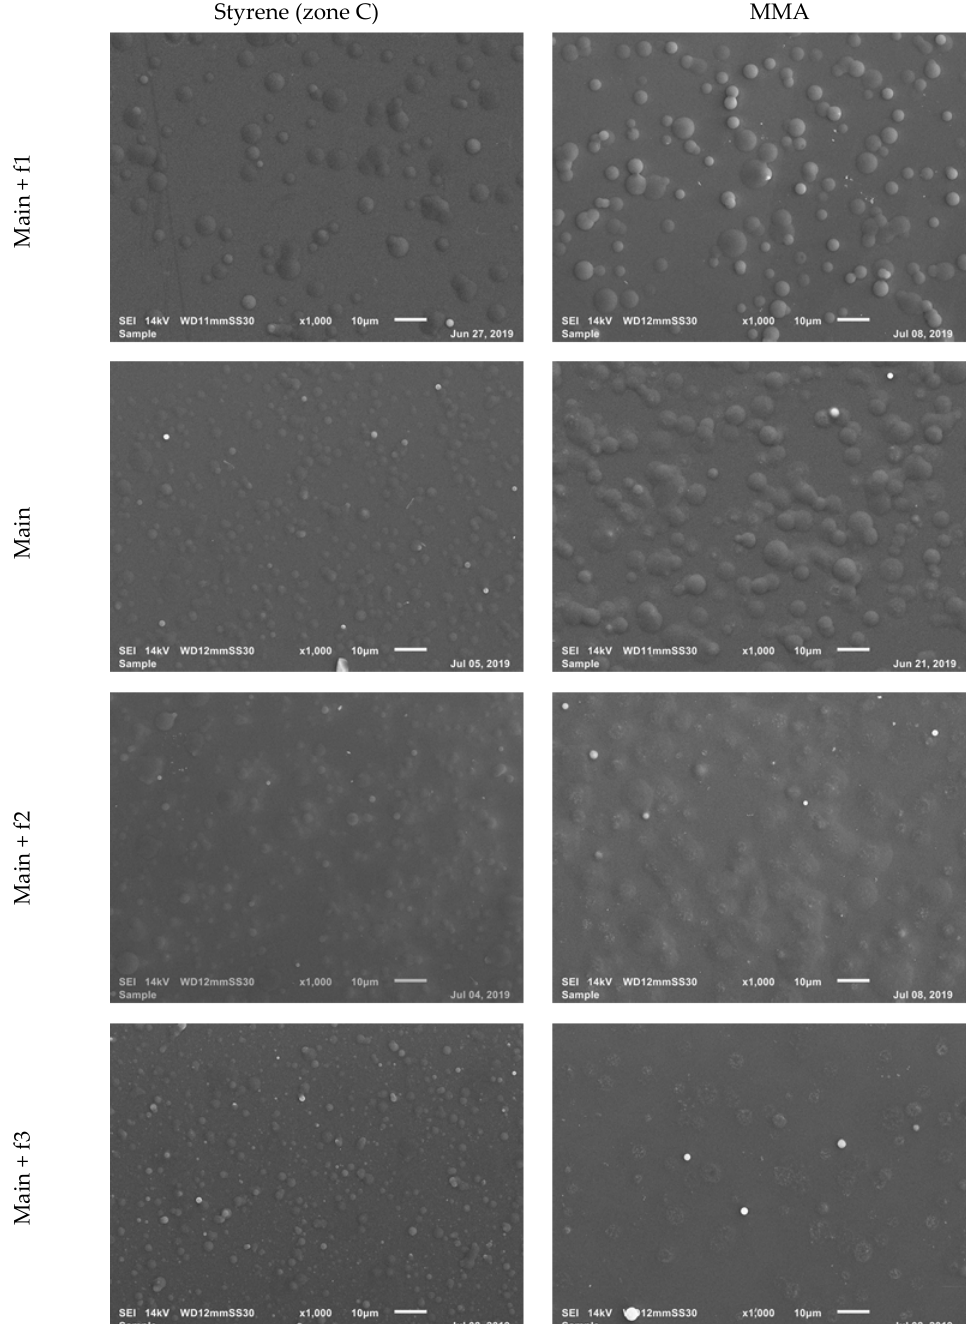
Figure 10. SEM images of the central zone of styrene (zone C) and MMA coatings deposited with different carrier gas flow rates.